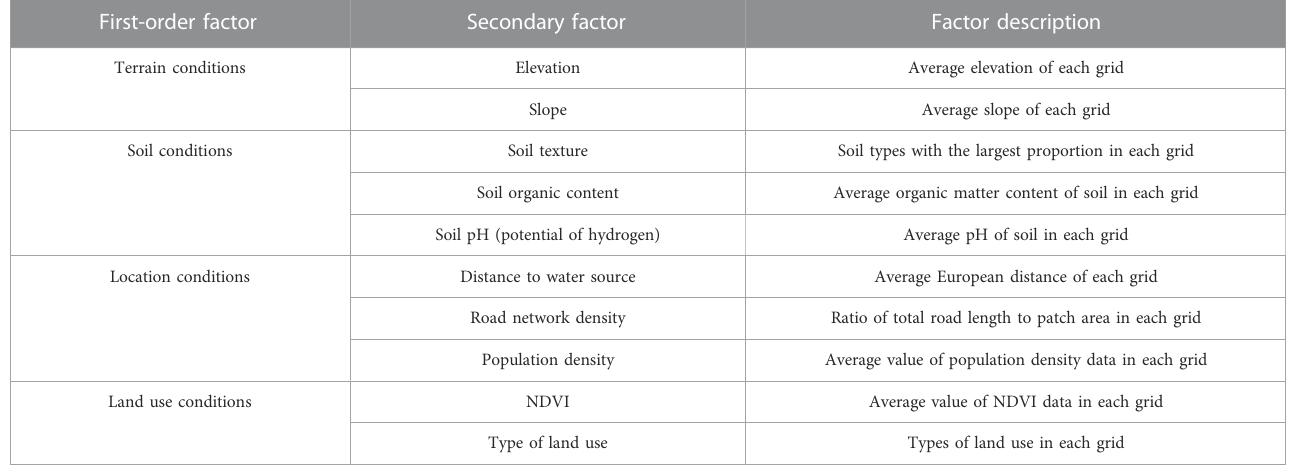
TABLE 1 Classi fi cation of ecological risk drivers in Savan